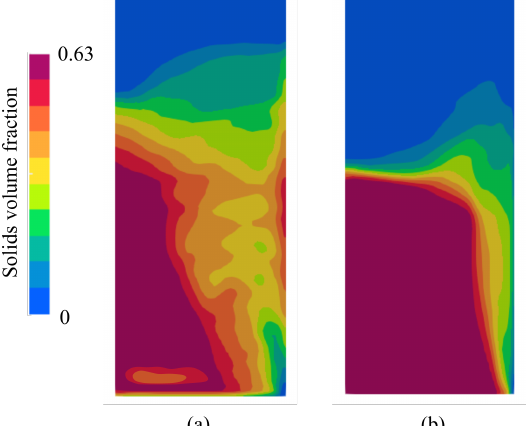
Figure 6. Time-averaged solids volume fraction distribution simulated with: ( a ) OpenFOAM and ( b ) MFiX.